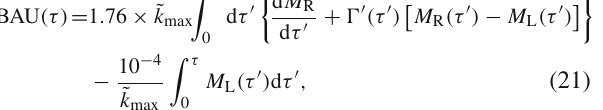
˜ ˜ k max (cid:4) k min in